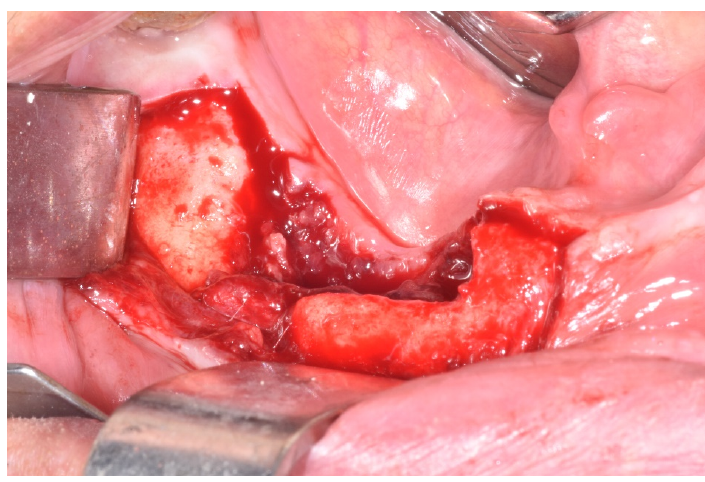
Figure 4. Removal of necrotic bone sequestrum revealing inflammatory reaction.